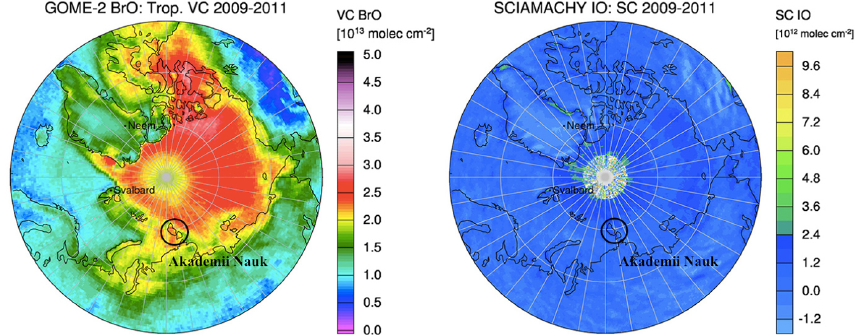
Figure 5. Atmospheric column averages of BrO and IO in the Arctic between 2009 and 2011. In the Arctic, IO concentrations are near the limit of detection by satellite (after Spolaor et al., 2014).